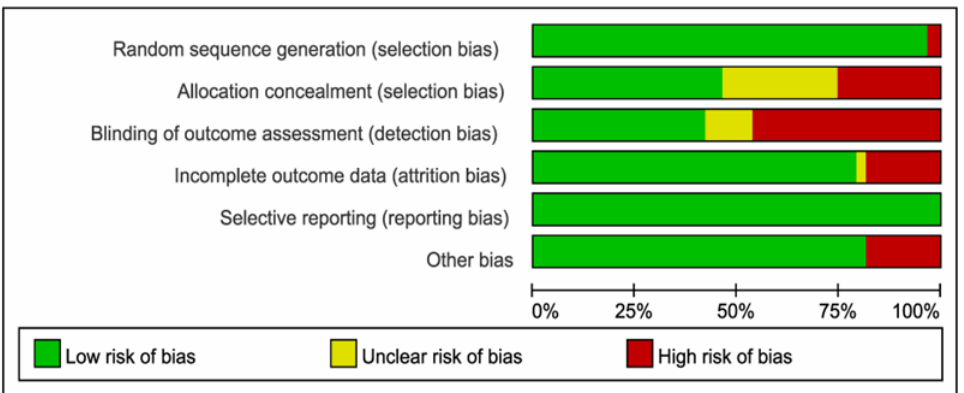
Figure 2. Risks of Bias within Studies.